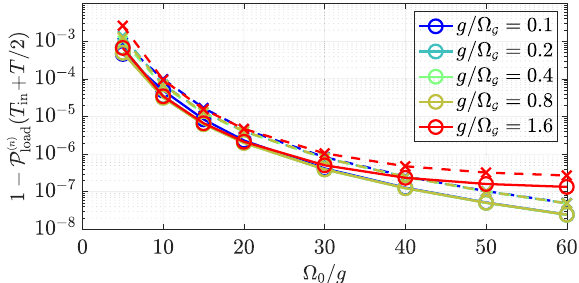
Fig. 5 Probability of failing at photon absorption. Probability not absorbing one- (solid lines) and two-photon (dashed lines) input states as a function the TLE-cavity detuning for different values of g = Ω G . Simulation parameters: κ C ¼ 6 Ω G , κ l = γ e = 0, T in = 4.3/ g , and T = 7/ g